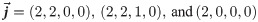
Comparison between j→=(2,2,0,0),(2,2,1,0),and(2,0,0,0).